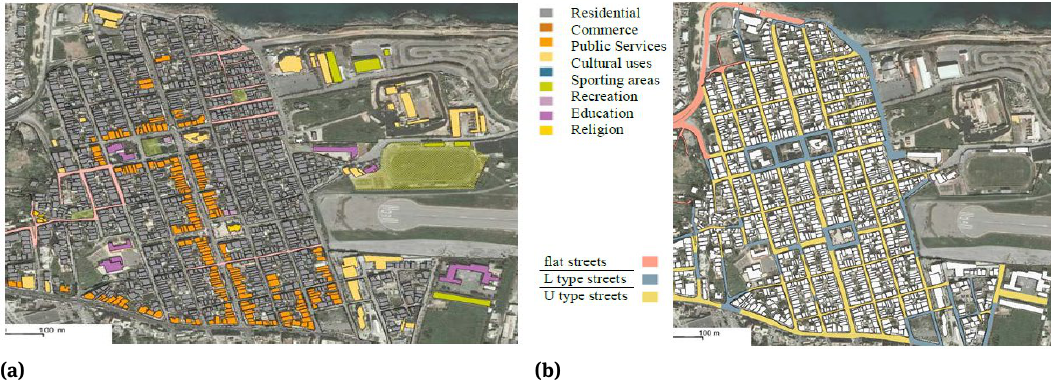
Fig. 2. Study area of Alikarnassos : (a) Land uses & (b) Road network typology.